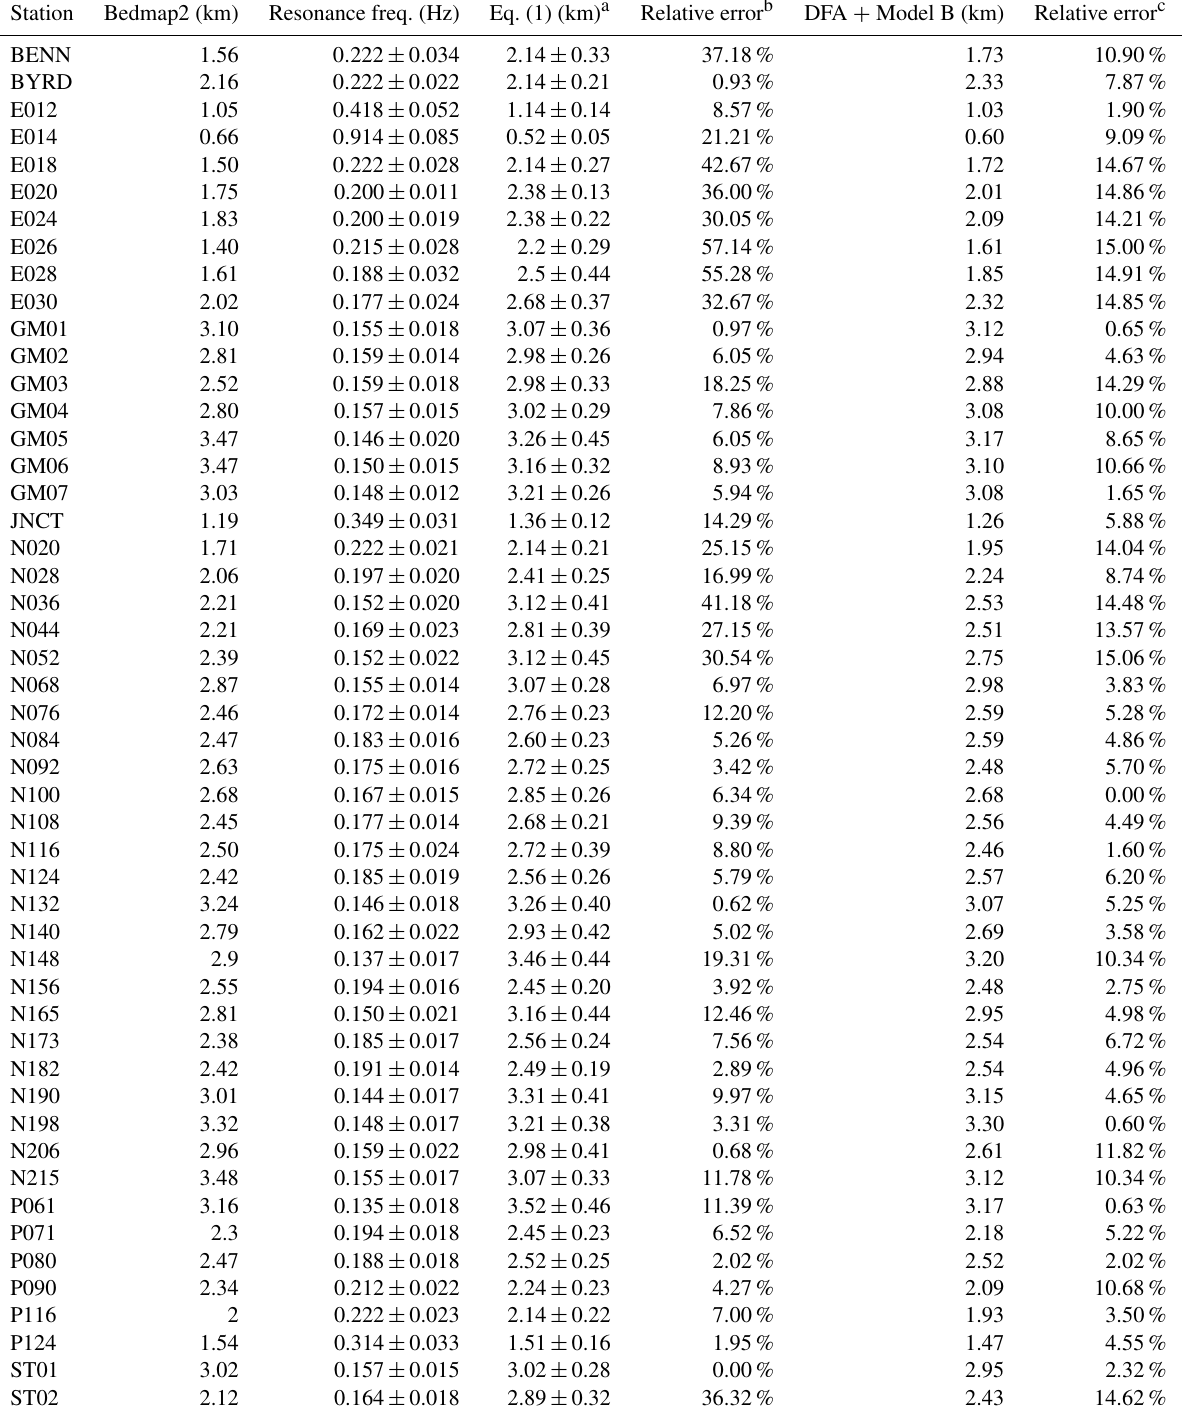
Table 1. Ice thickness results obtained from this study (The resonance frequencies f 0 and the corresponding standard deviations σ are listed in column 3. The Eq. (1) estimates and the associated errors (cid:49)h are listed in column 4. The relative errors of the Eq. (1) and DFA + Model B estimates to the Bedmap2 ice thickness are listed in column 5 and